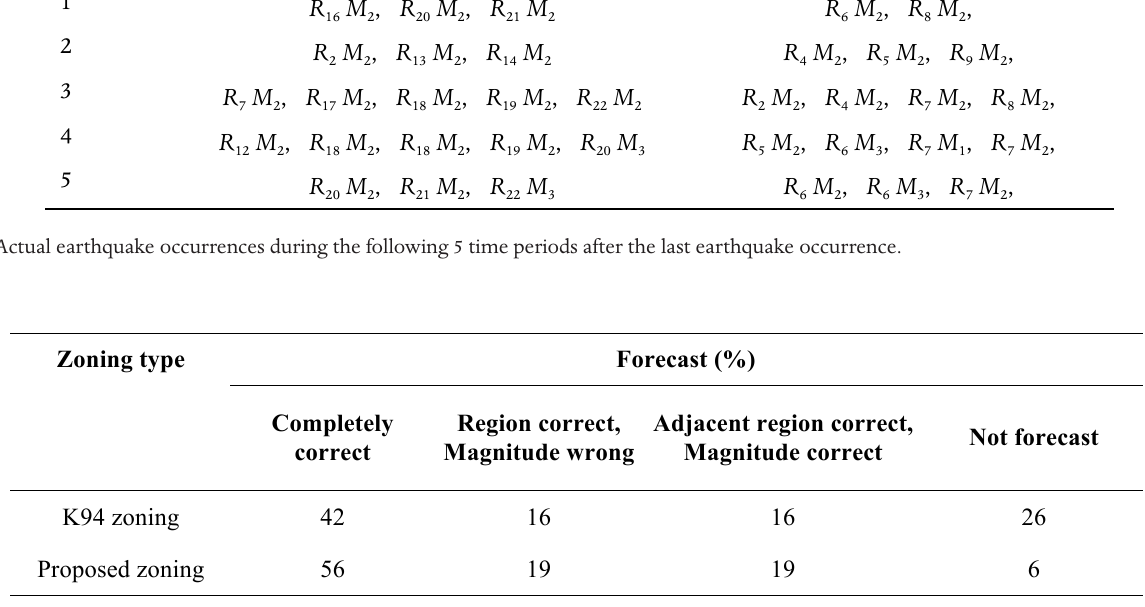
Table 6. Summary of the results of the forecasting.